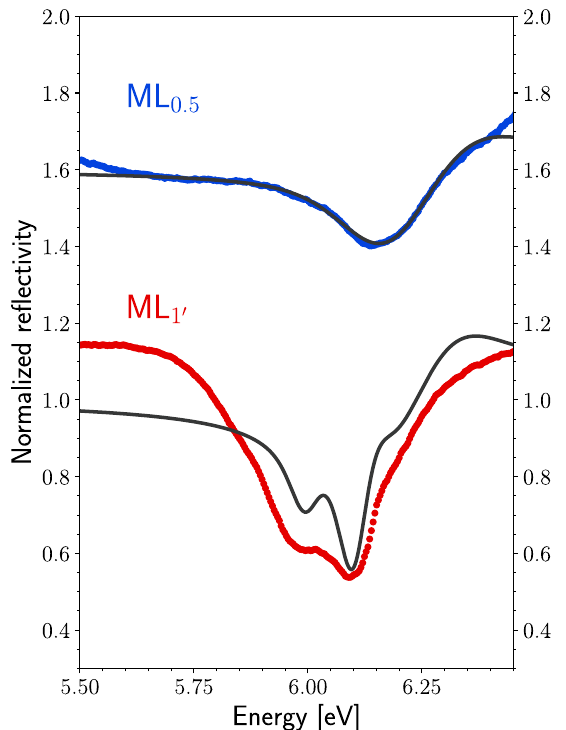
FIG. 6. Reflectivity spectrum around the excitonic resonance in samples ML 0 and ML 1 0 , at 8 K. The spectra are norma- . 5 lized to the reflectivity spectrum of the bare graphite substrate. Experimental data (symbols), fit of the normalized reflectivity (solid